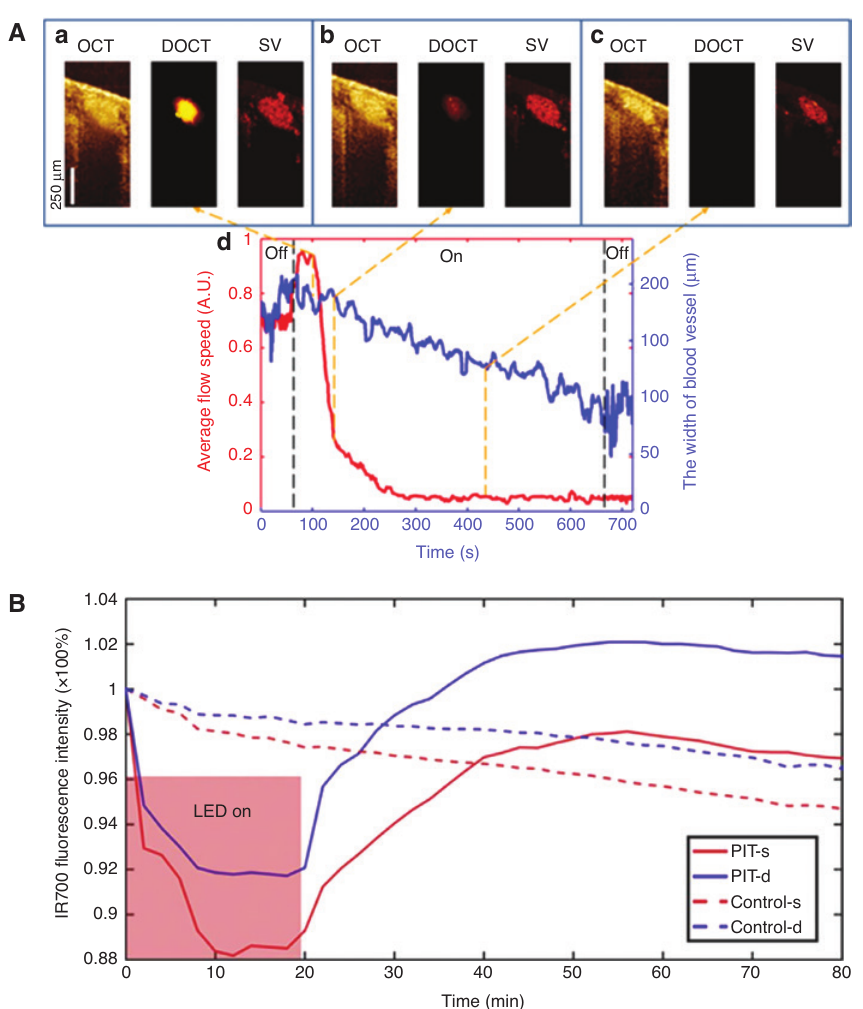
Figure 4 Hemodynamic changes in tumors induced by